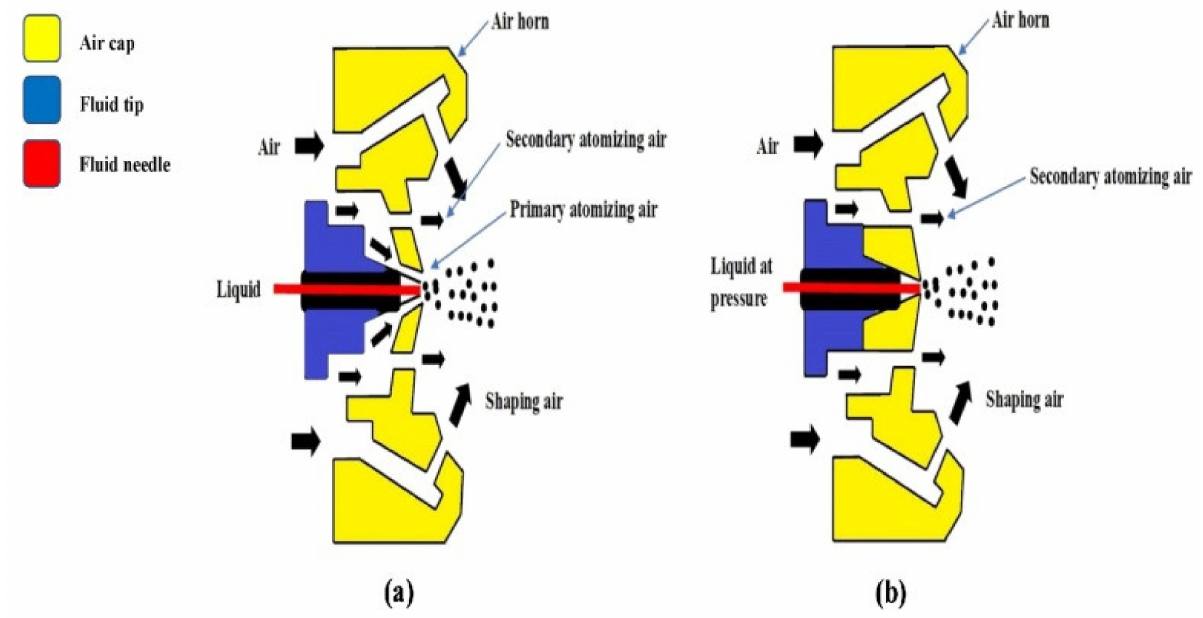
Figure 5. ( a ) Air spray atomization, ( b ) Air-assisted airless atomization [187]. (Reprinted